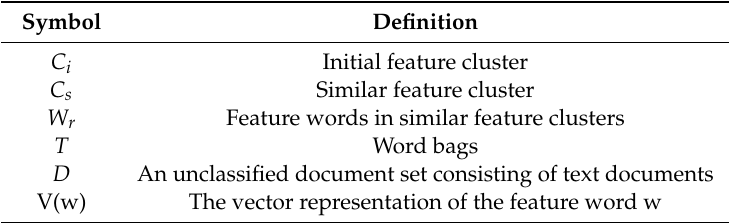
Figure 1. The framework of the two-stage feature clustering (TSFC) approach. Table 1. Symbols and their